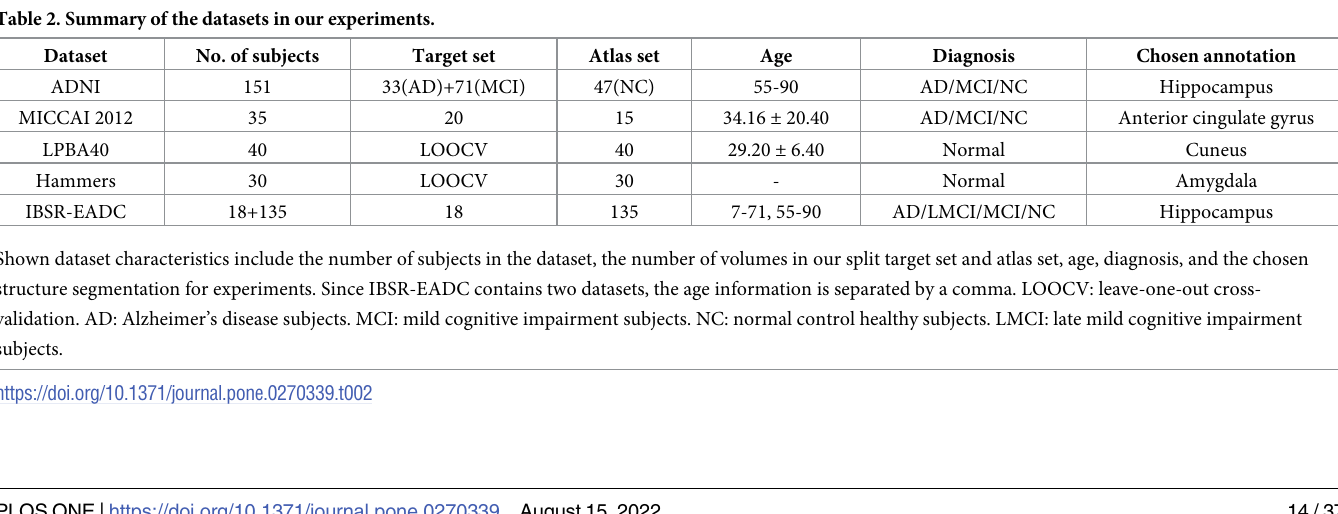
Table 2. Summary of the datasets in our experiments. Dataset